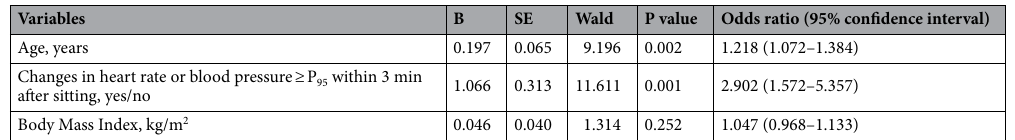
Table 3. Binary logistic regression analysis for possible risk factors for sitting